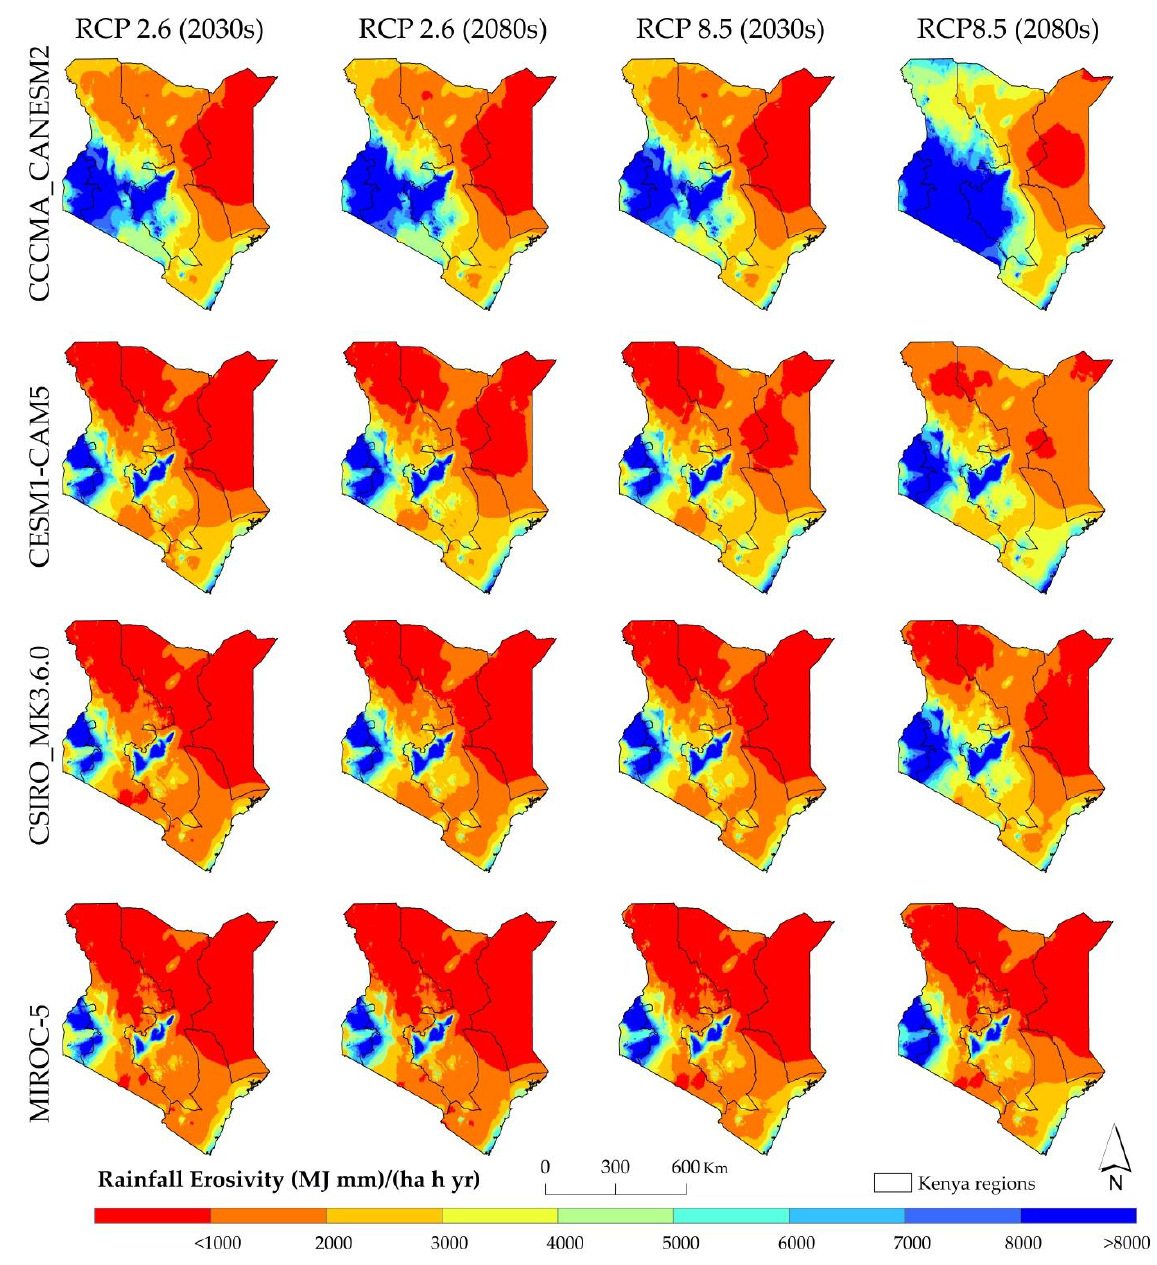
Figure 10. Rainfall erosivity projections in Kenya for the periods of the 2030s and 2080s under the RCP 2.6 and 8.5 scenarios, driven by CCCMA_CANESM2, CESM1-CAM5, CSIRO_MK3.6.0 and MIROC-5 GCMs.